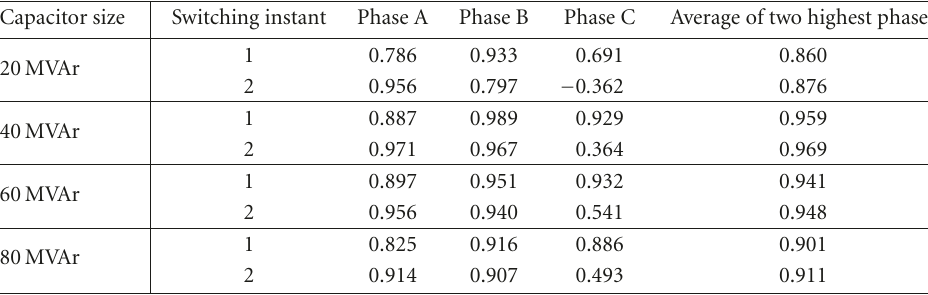
Table 1: Results of isolated capacitor switching.